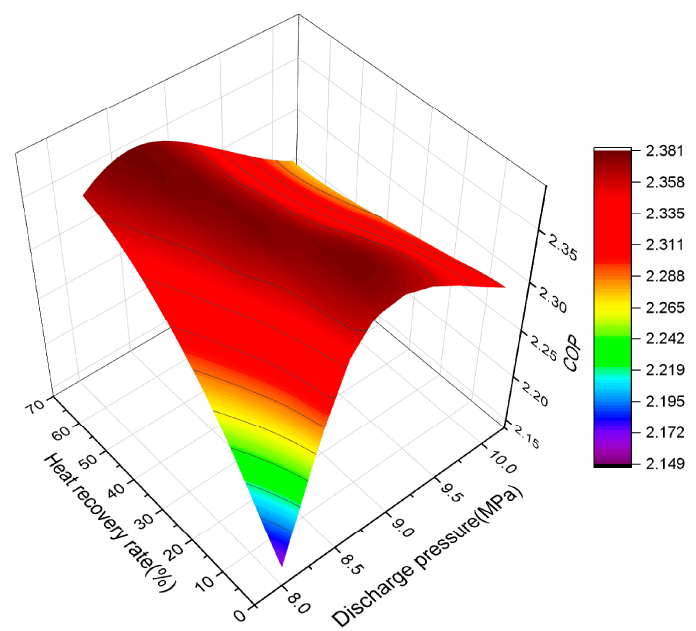
Figure 8. The collaborative optimization of the discharge pressure and heat recovery rate under − 10 °C in ambient temperature.